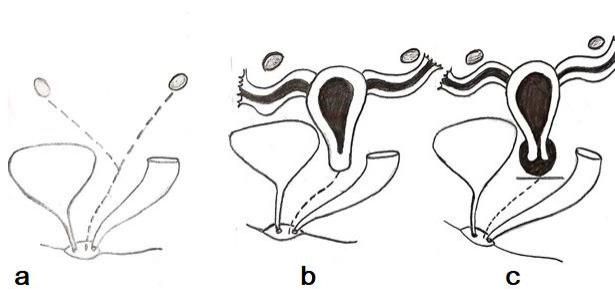
Figure 1: Rectovestibular fistula associated with- a) MRKH (vaginal agenesis with varying degrees of uterine agenesis/ hypoplasia, b) Cervicovaginal atresia (vaginal and cervical agenesis with the normal functioning uterus), c) Distal vaginal atresia (atresia of the distal vagina, hematocolpos of the proximal vagina)-(Adapted with permission from Kisku et al. Int Urogynecol J.